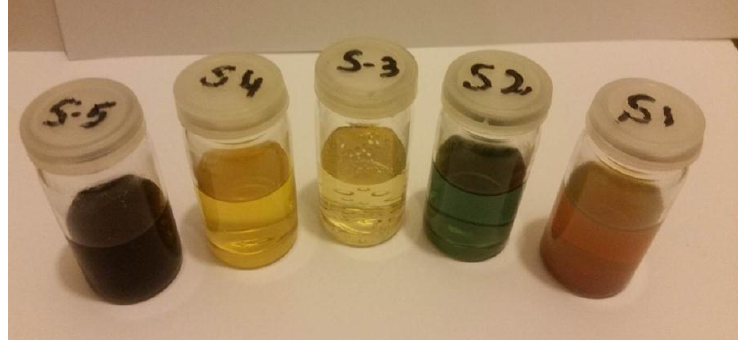
Figure 1. The manifestation of different colors of silver nanoparticle samples, the type of sample is written on the lid of each sample bottle.